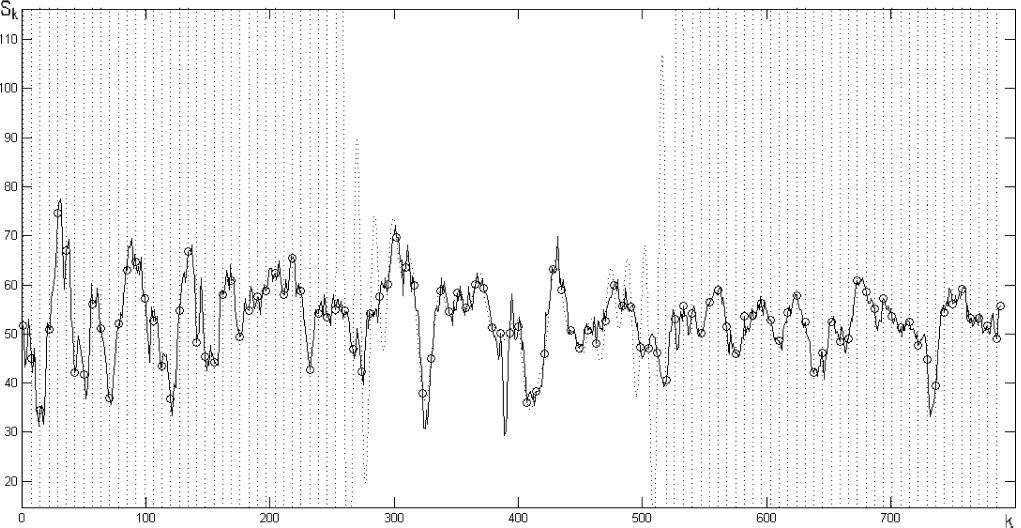
Fig. 7. PMI Composite Index data (the solid line) and the Lagrangian interpolant (the dotted line). Circles denote nodes of the equispaced